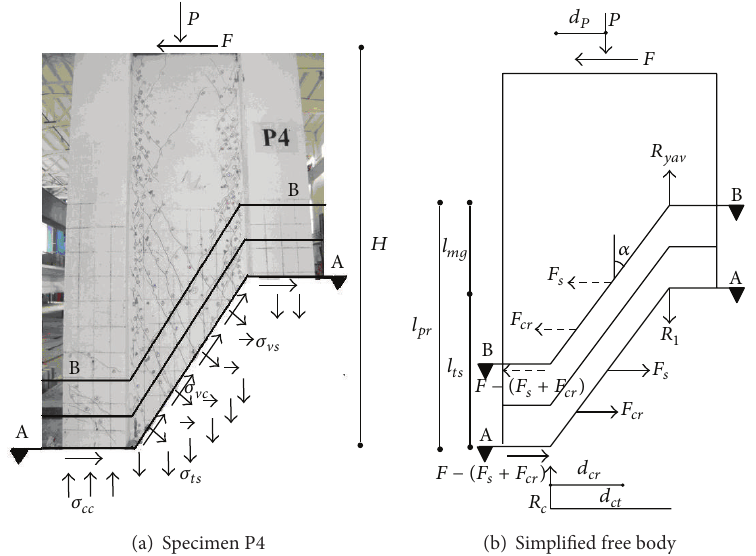
Figure 7: Free body diagrams for evaluating spread of plasticity in neotype column-slab